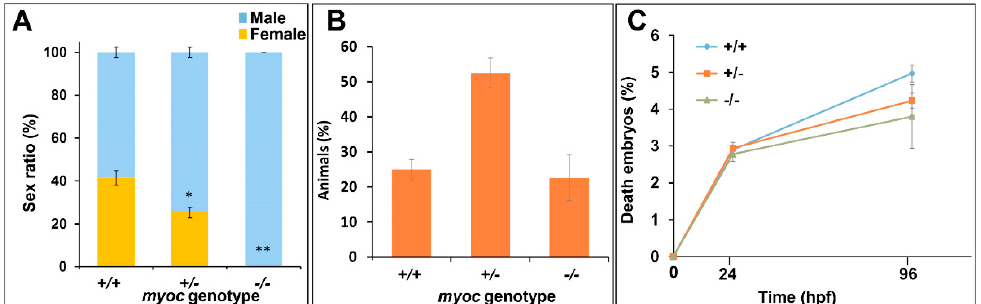
Figure 8. Absence of females among myoc KO zebrafish. Eight +/- myoc siblings were mated, and 30–35 embryos per cross were randomly selected (n = 256), raised to adulthood and genotyped by PAGE. The sex ratio as a function of the myoc genotype was calculated ( A ). Observed genotype proportions ( B ) and embryo survival ( C ). Values are expressed as the mean ± standard error of the mean (SEM). Asterisks indicate statistical significance compared to +/+. * p = 0.00038. ** p = 0.00001. +/+: wild-type; − / − : myoc KO.